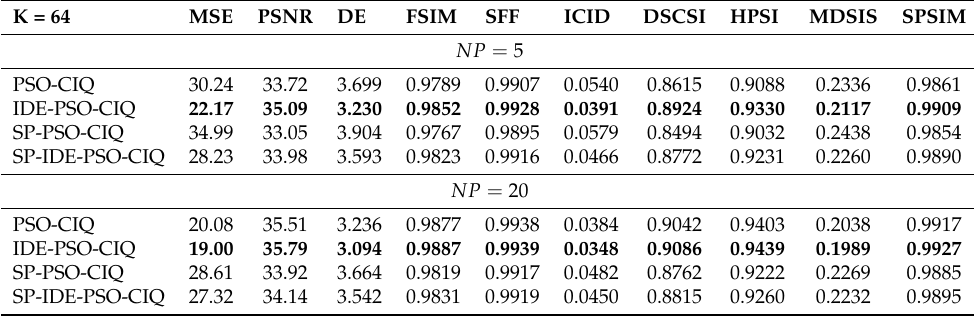
Table 4. Comparison of pixel and superpixel versions of PSO-CIQ and IDE-PSO-CIQ ( K = 64).